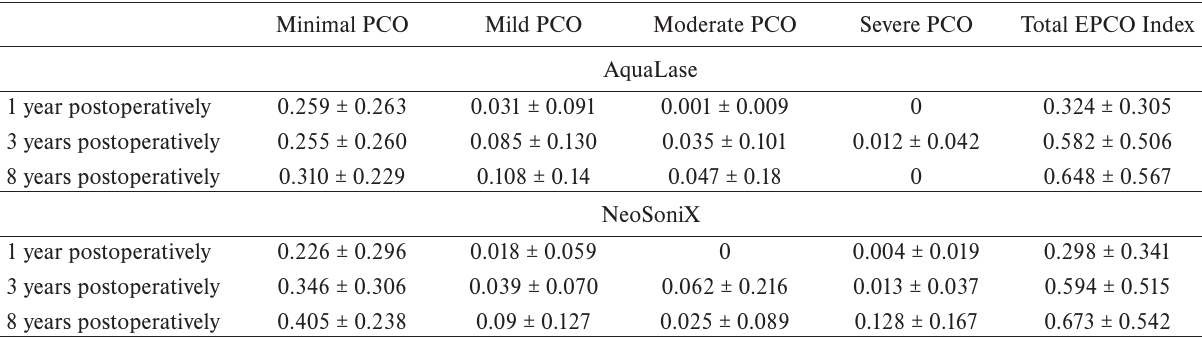
Table 2. Mean Evaluation of Posterior Capsule Opacification 2000 Indexes With Standard Deviation of All Grades and of Total Evaluation of Posterior Capsule Opacification Index for AquaLase and NeoSoniX Group, 1, 3, and 8 Years After Cataract